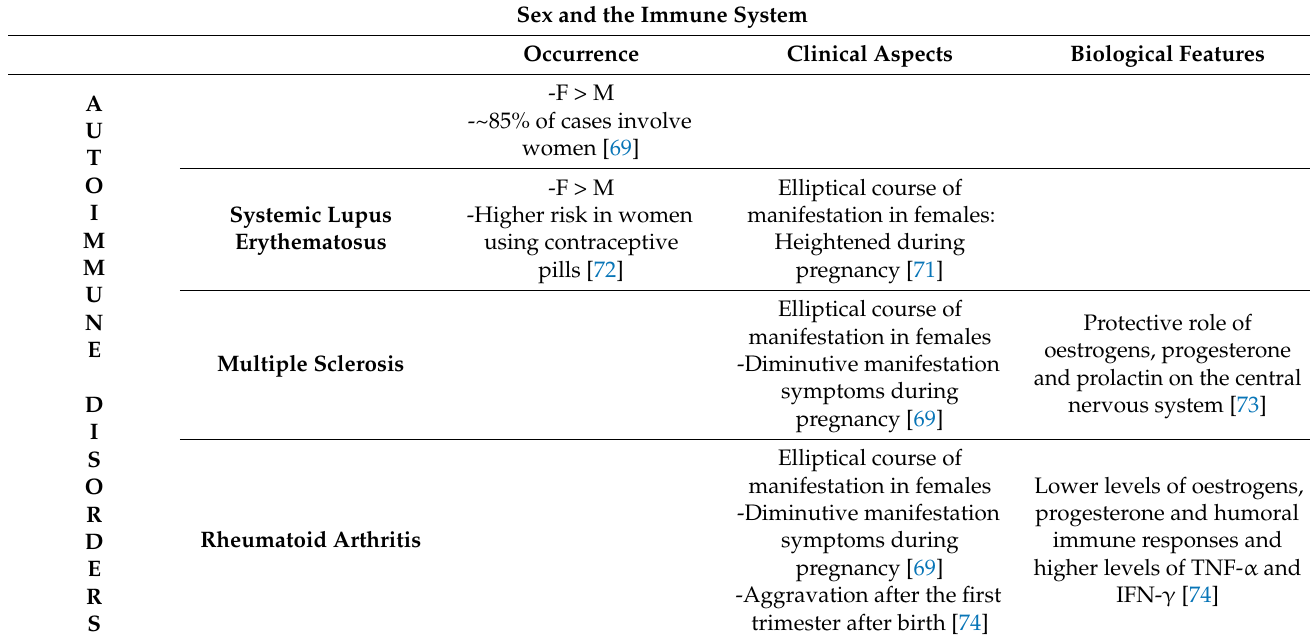
Table 2. Sex differences in immunological responses. The occurrence of autoimmune diseases is significantly higher in women than in men (up to 9:1). Some clinical aspects, mainly associated with pregnancy, and some biological features are reported. As concerns infectious diseases only some examples have been provided. Of note, COVID-19 severity and lethality are significantly higher in